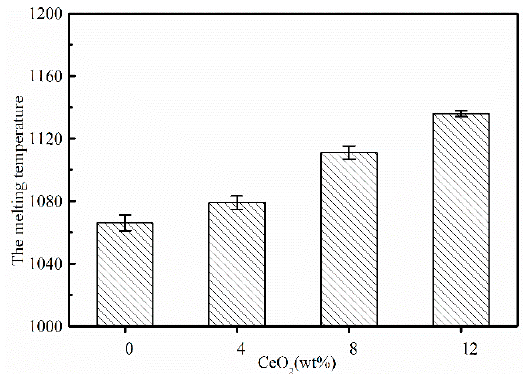
Figure 3. The melting temperature of experimental mold fluxes with different CeO 2 contents.